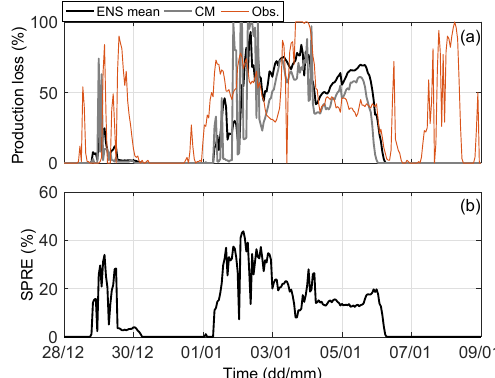
Figure 7. Site A. (a) Forecasted production loss in percent. Black line is the ensemble mean using ENS, grey line is the CM and red line is the observed production loss. (b) The related spread of the ensemble members in